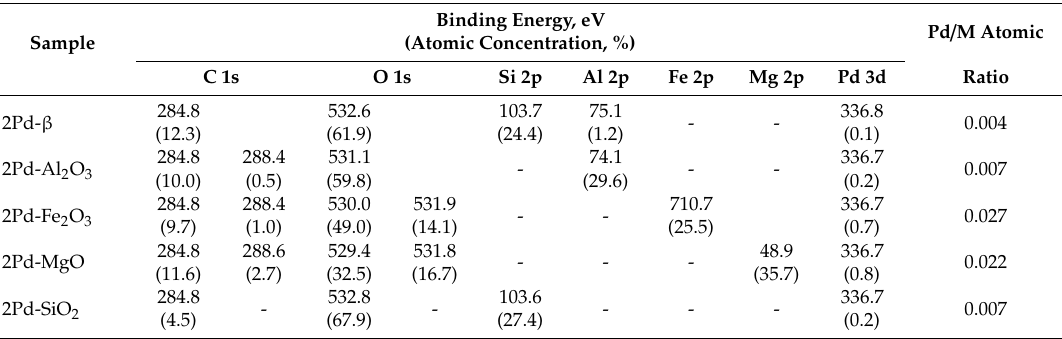
Table 3. XPS data of Pd-based catalysts (Pd content: 2 wt.%).